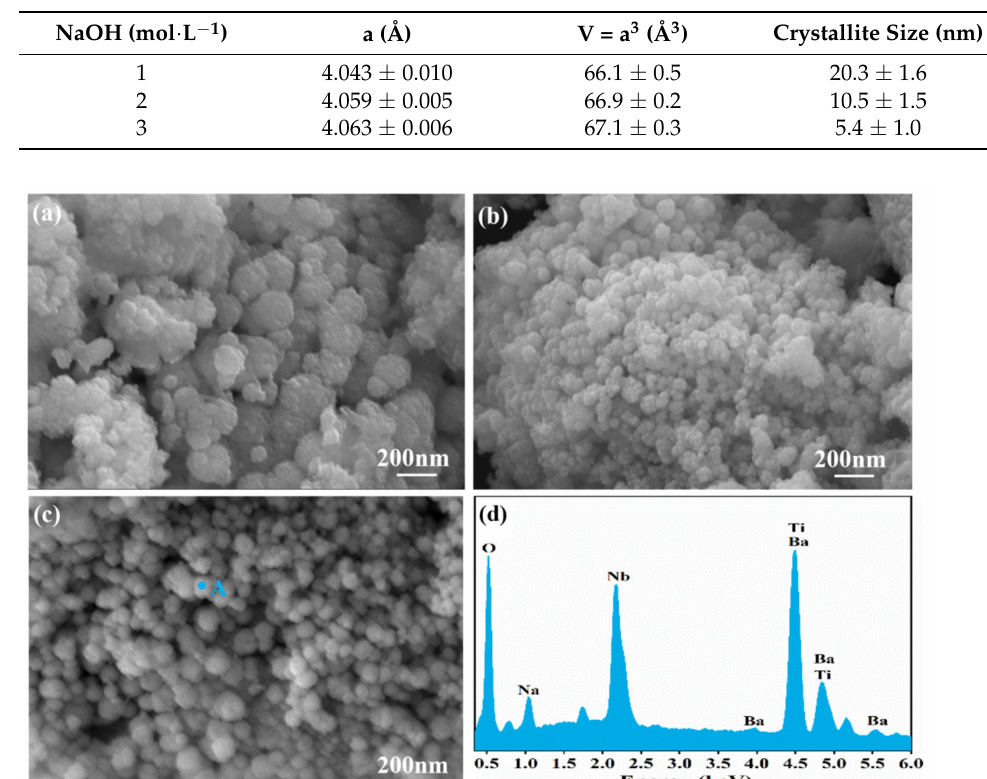
Figure 8. SEM image of BNTO powder, synthesized in solvents containing different concentrations